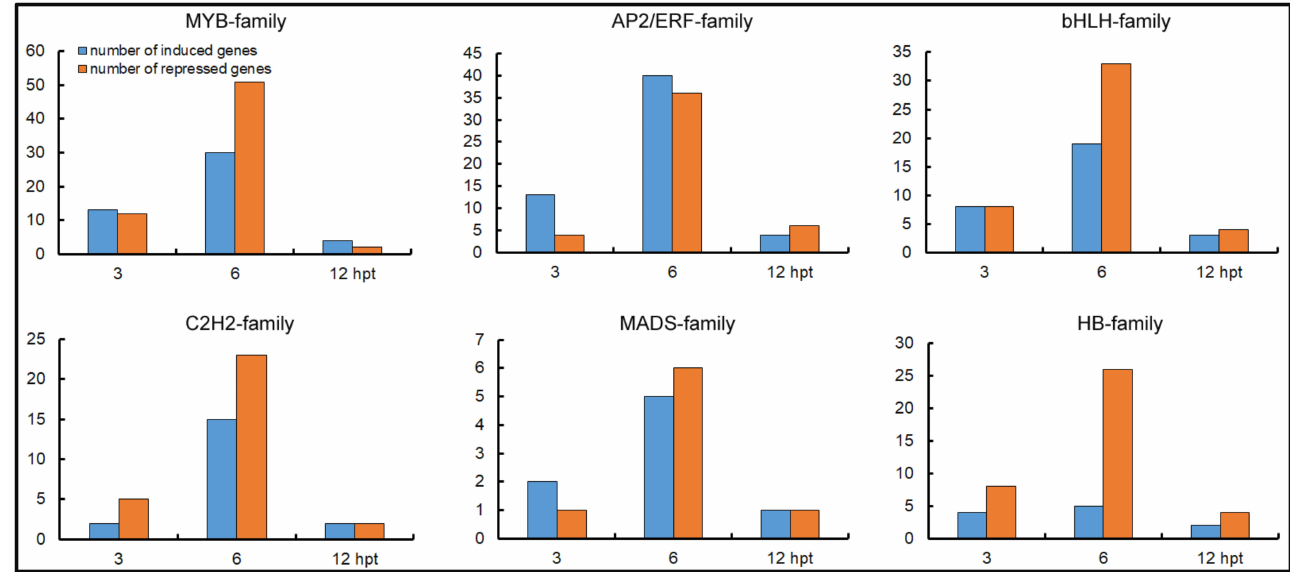
Figure 7. Expression patterns of six important TF families regulated by SCR96. Genes with mRNA abundance induced or repressed by more than twofold were grouped into